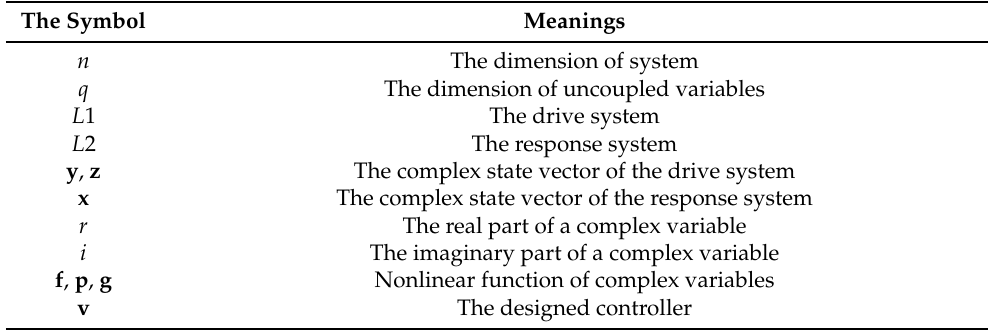
Table 1. The descriptions of all